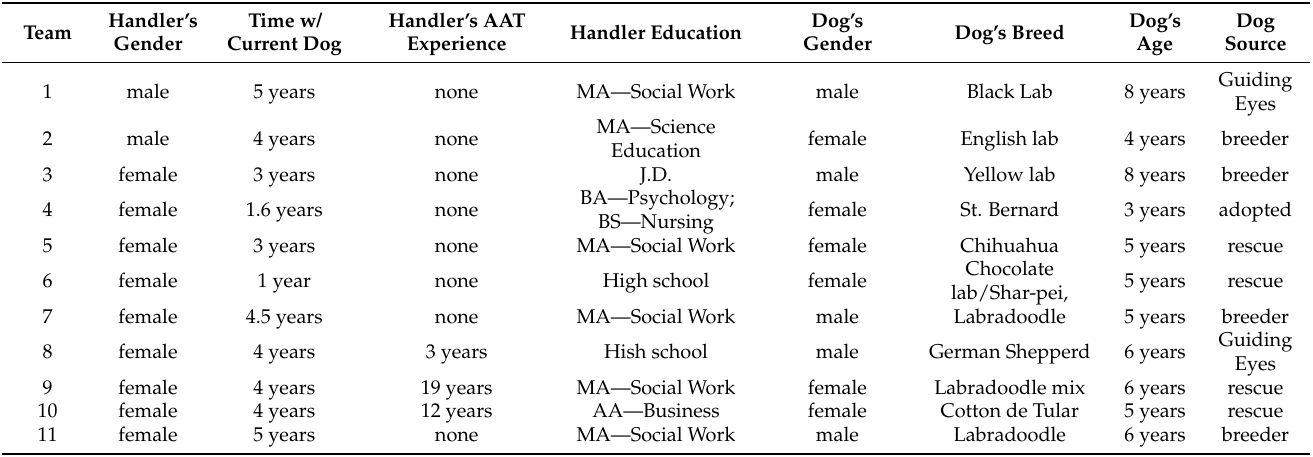
Table 1. Dog-Handler Team